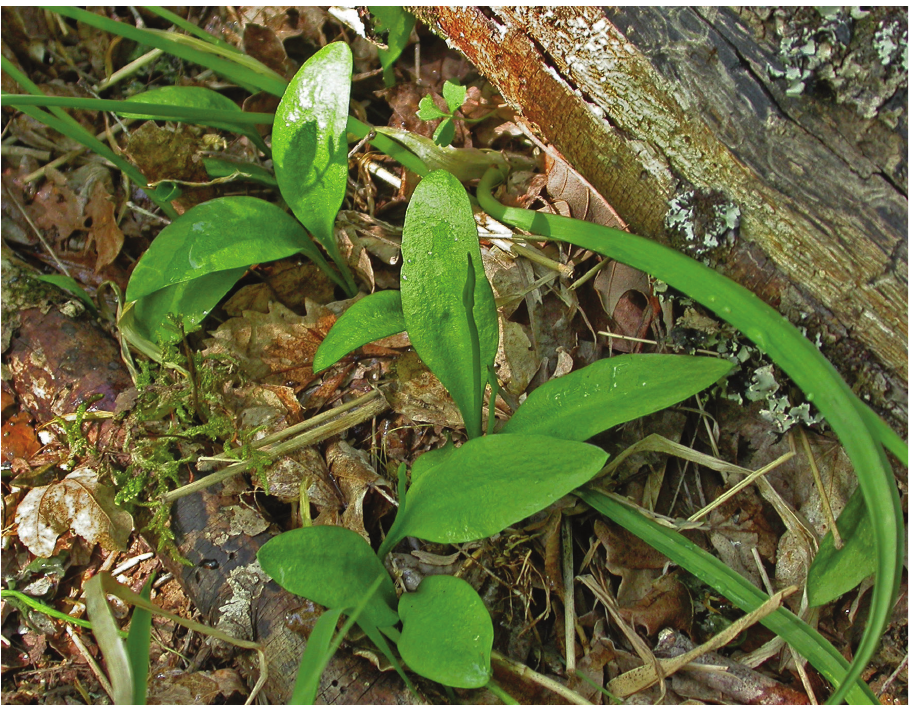
Figure 7. Ophioglossum azoricum photographed in the Selva del Lamone (Ischia di Castro, Viterbo, Latium). Picture by S.